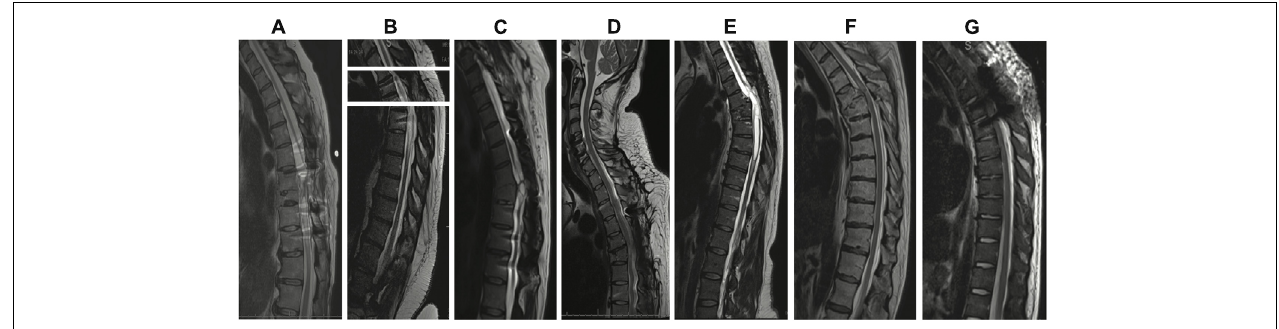
FIGURE 1 | T2 sagittal thoracic magnetic resonance imaging (MRI) obtained prior to enrollment. (A) Subject 1: spinal cord changes include dorsal tethering at T7 and syrinx from T8 to T10. (B) Subject 2: syrinx at T7. Owing to coronal scoliosis, a single sagittal image did not provide a full view of the spinal canal. A composite image of three different slices with the midline of the central canal kept as the axis is shown. (C) Subject 3: T8 cord injury with cystic changes at the same level. (D) Subject 4: T5 cord injury. (E) Subject 5: T5 cord injury and syrinx extending from T5 to T7. (F) Subject 6: T5 cord injury. (G) Subject 7: T4 cord injury.